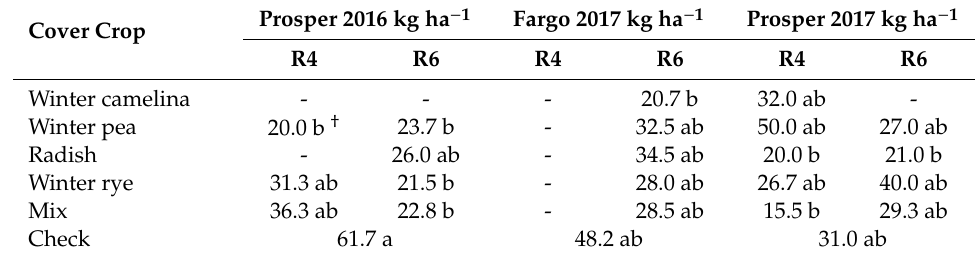
Table 6. Mean fall soil NO 3 -N from 0 to 60 cm in depth in Fargo in 2017 and Prosper, ND, in 2016 and 2017.